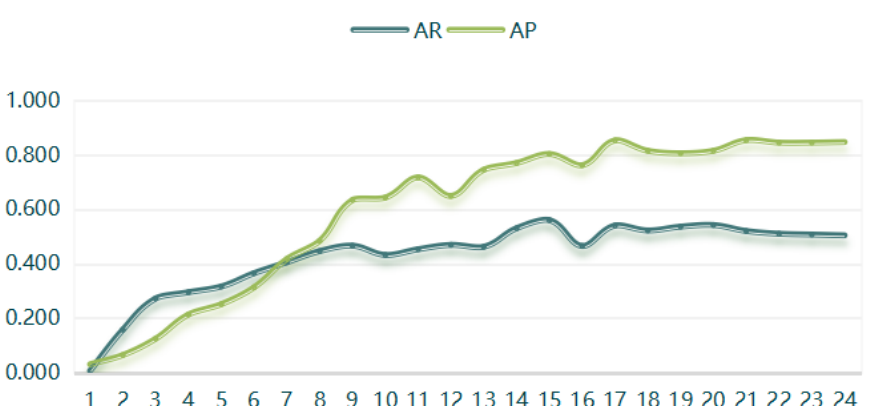
Figure 7. AR and AP comparison chart.